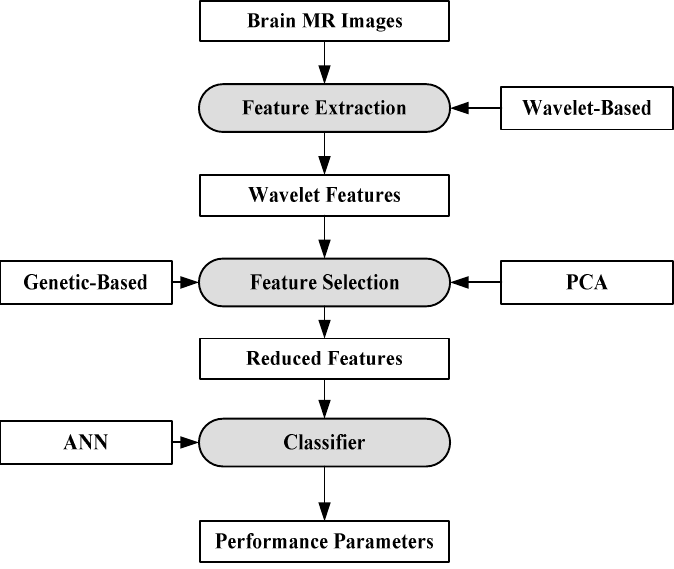
Figure 5. Process model of ANN‐based classification model [63].